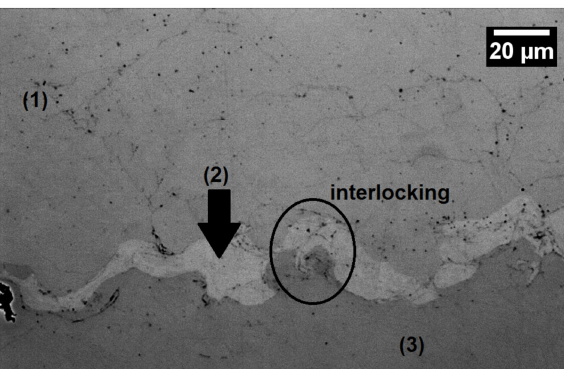
Figure 5. OM image of the Dycomet 1008 layer. ( 1 ) Maraging, ( 2 ) Dycomet 1008, ( 3 ) C-steel